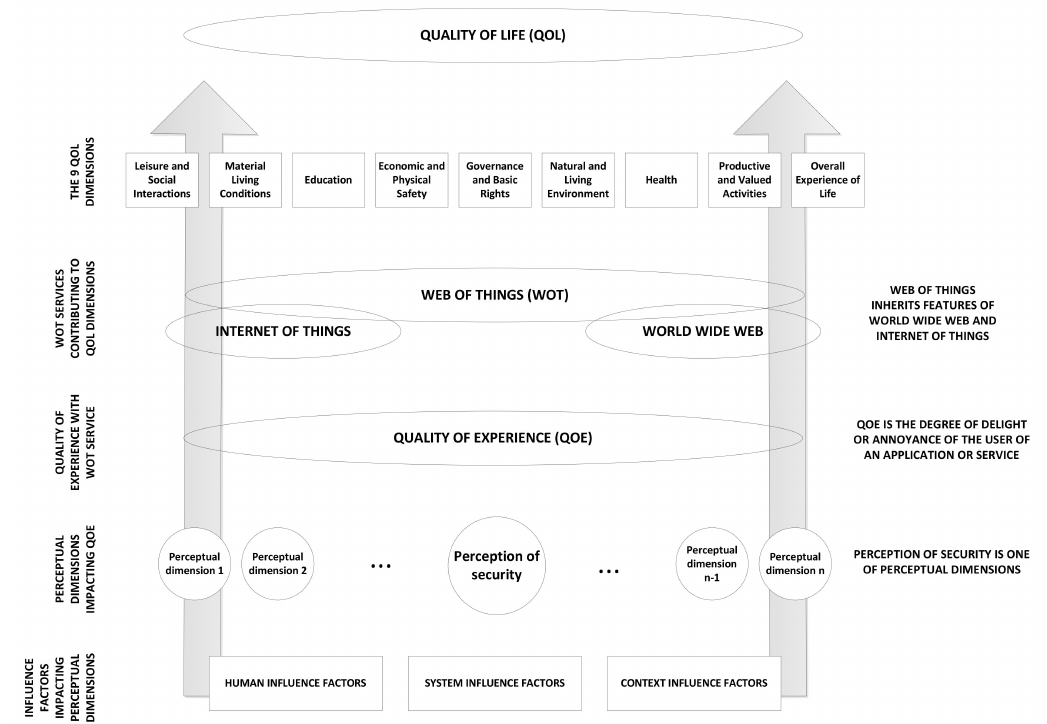
Figure 1. Dependencies between QoL, QoE, security perception, and influence factors in WoT—a layered